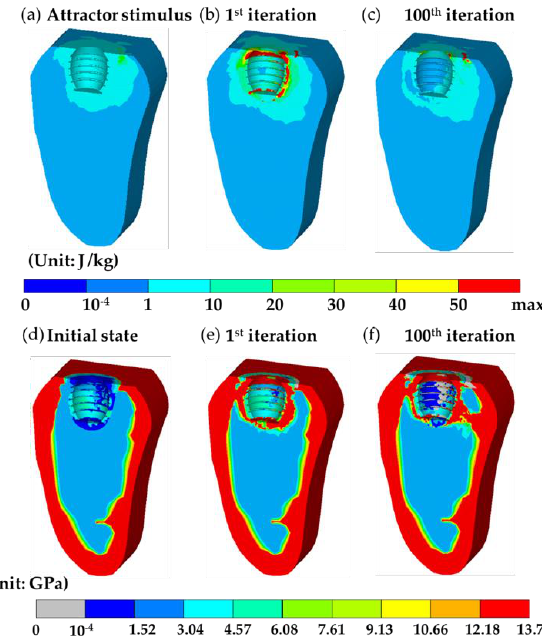
Figure 5. The results generated by the current model. ( a ) The target distribution of the attractor stimulus 𝐾(𝑟⃑ ) based on the natural tooth. ( b , c ) are bone remodeling stimulus ( 𝑆 𝐵𝑅 ) at the 1st and 100th iterations. ( d – f ) are the corresponding distribution of Young’s modulus during the bone remodeling process at the initial state, 1st, and 100th iteration. Materials 2019 , 12 , x FOR PEER REVIEW